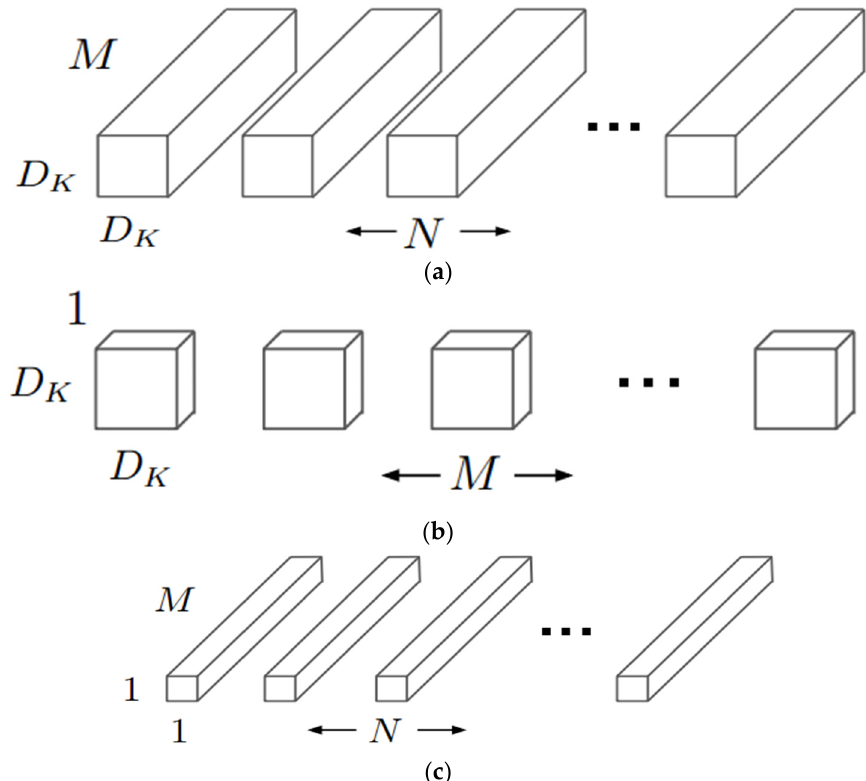
Figure 2. ( a ) Standard convolution. ( b ) Depthwise convolutional layers. ( c ) Point convolution: 1 × 1 convolution layer in depthwise separable convolution.